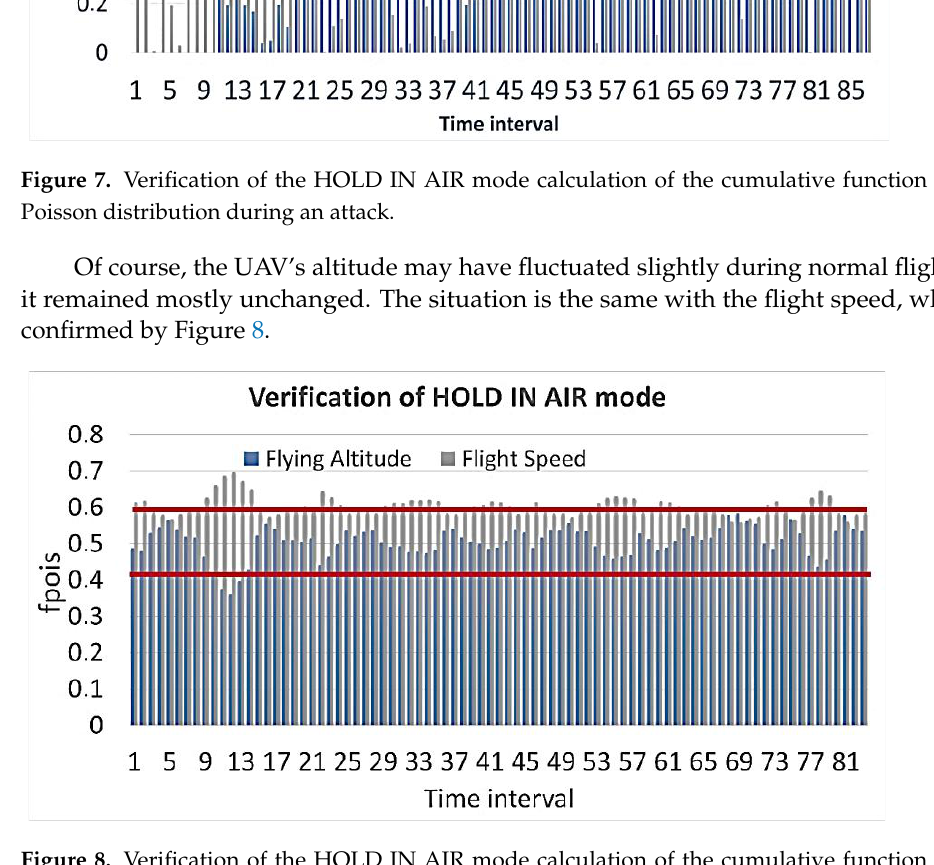
Figure 8. Verification of the HOLD IN AIR mode calculation of the cumulative function for the Poisson distribution.